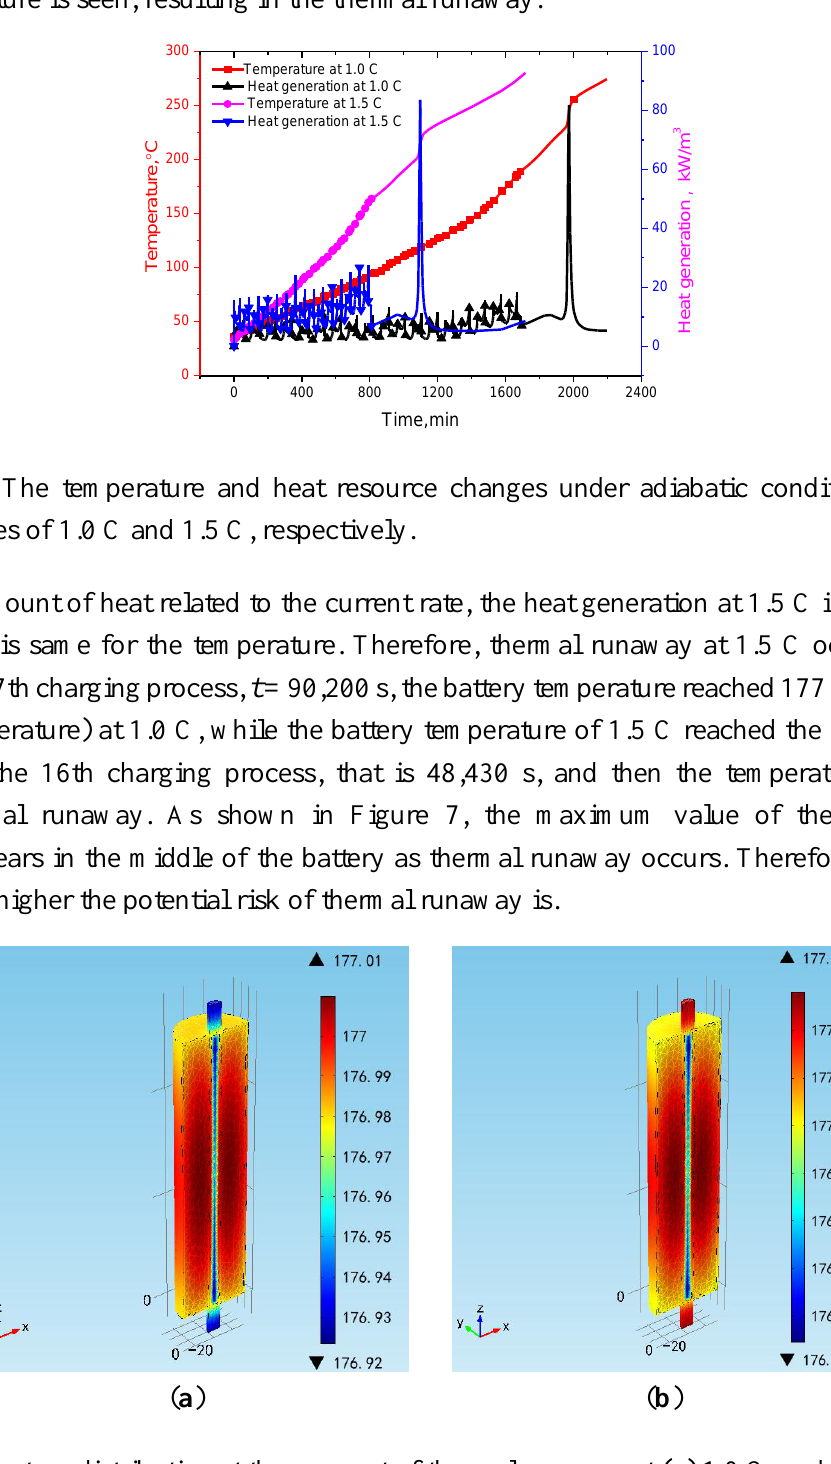
Figure 7. Temperature distribution at the moment of thermal runaway at ( a ) 1.0 C; and ( b ) 1.5 C